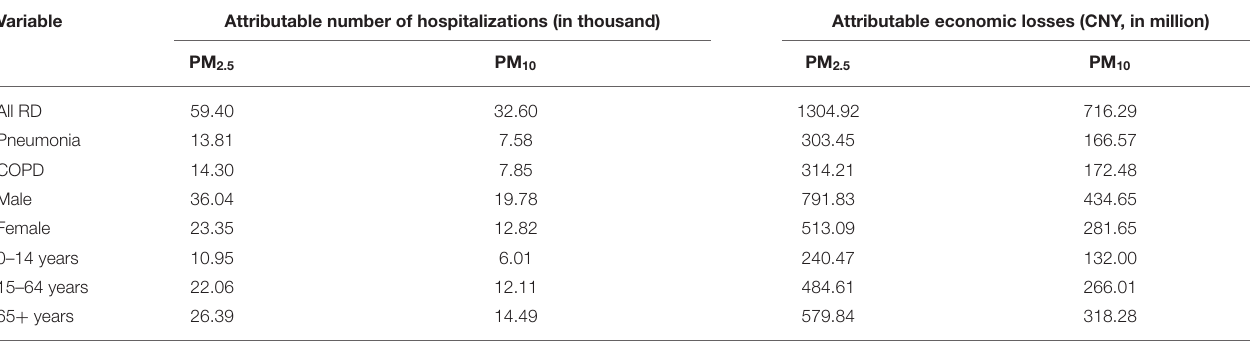
TABLE 2 | The number of RD hospitalizations and economic losses attributable to PM 2.5 and PM 10 in Wuhan, China, from 2015 to 2020.